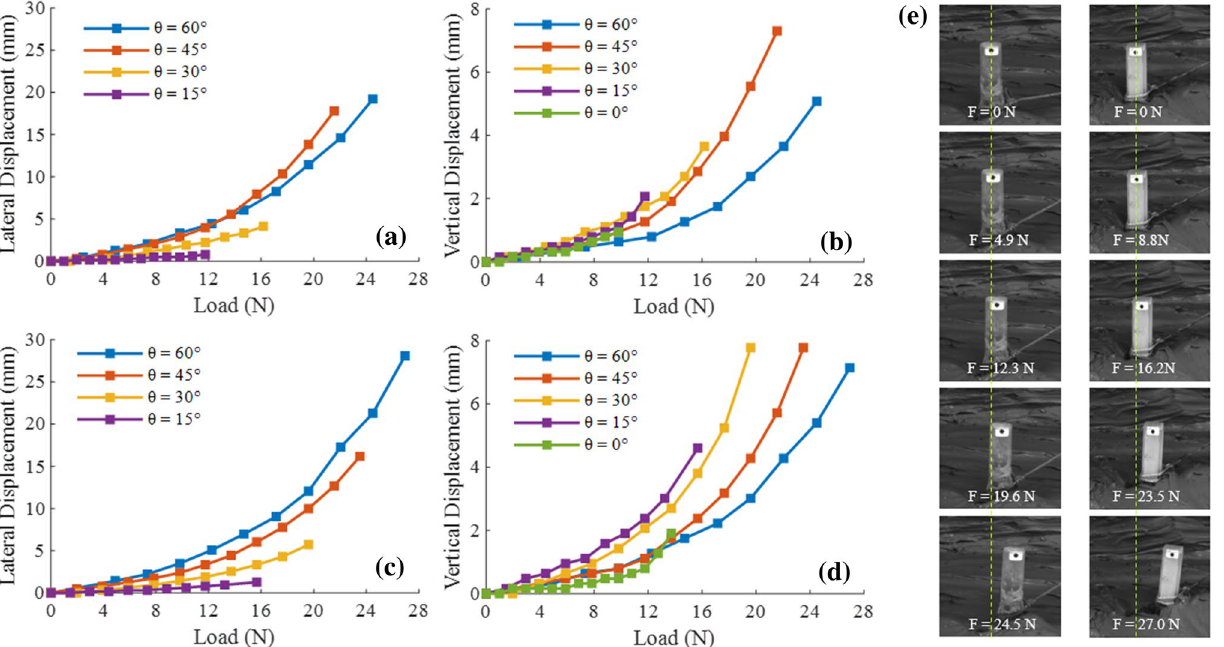
Figure 5. Lateral and vertical displacement–load curves with variables angle of circular pile ( a , b ) and square pile ( c , d ), and the failure process of circular pile (left column) and square pile (right column) with θ = 60° ( e ).